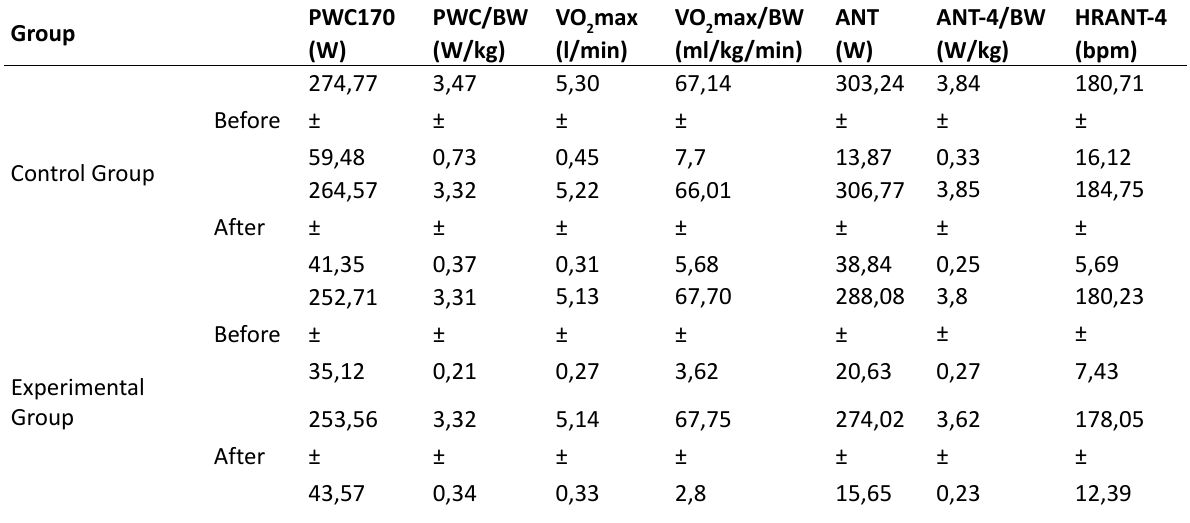
Table 3. Submaximal functional test results.